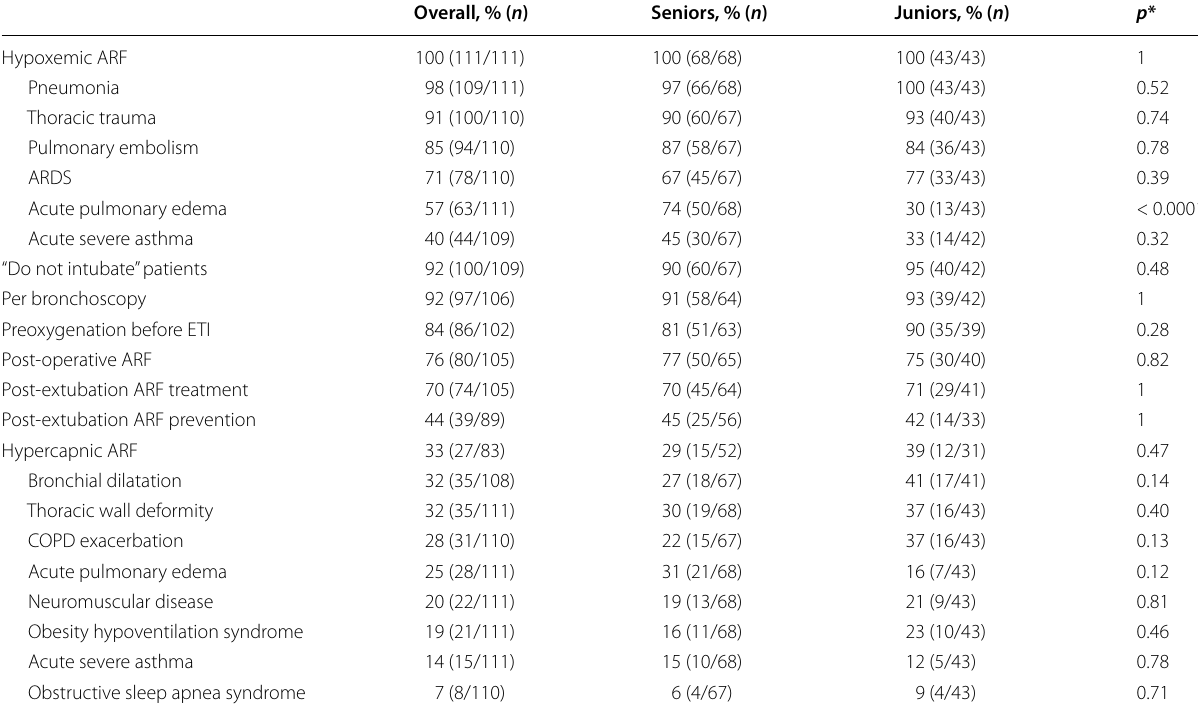
Table 1 Proportion of ICU physicians estimating the different potential indications of high-flow nasal cannula therapy as “good” or “very